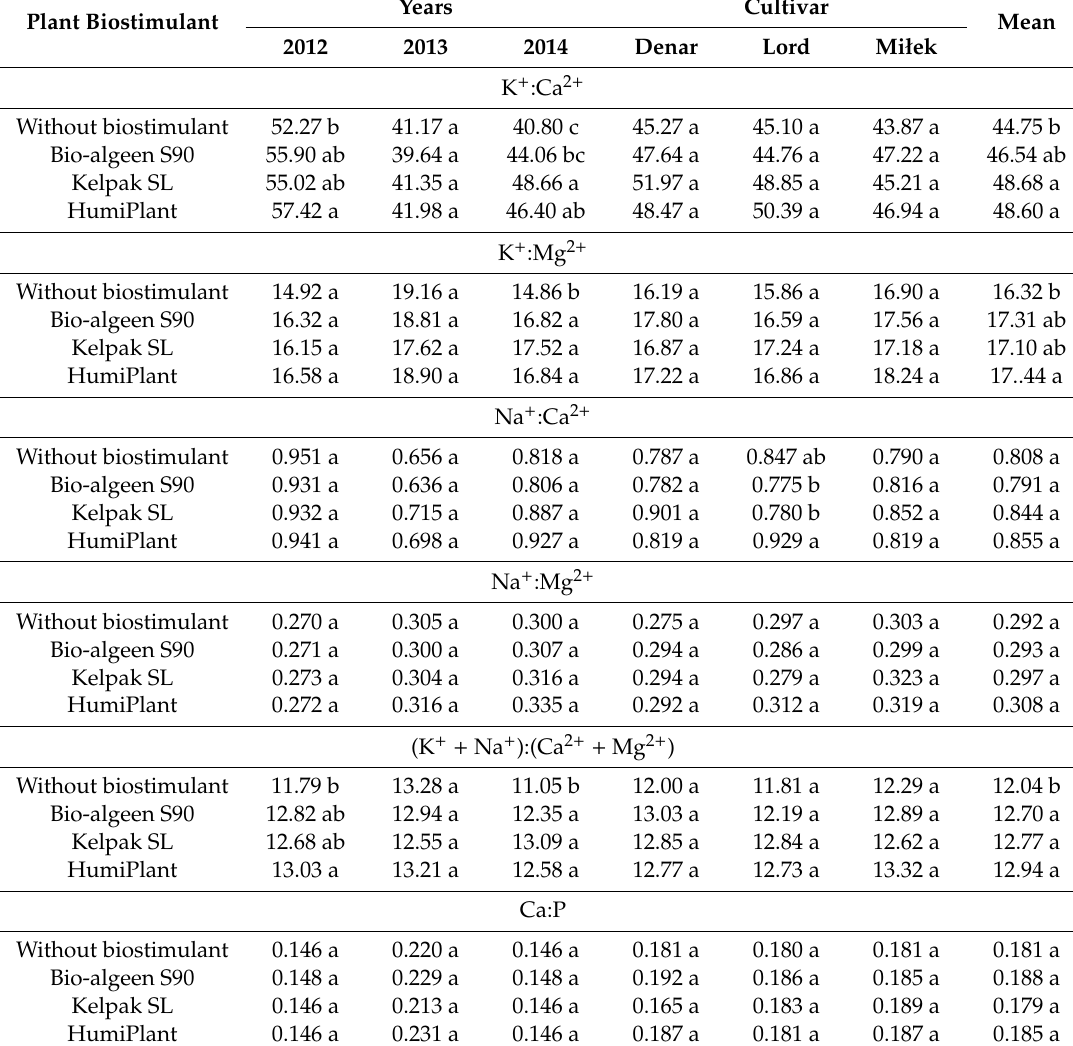
Table 5. Macronutrient ionic ratios in potato tubers in relation to plant biostimulant. Plant